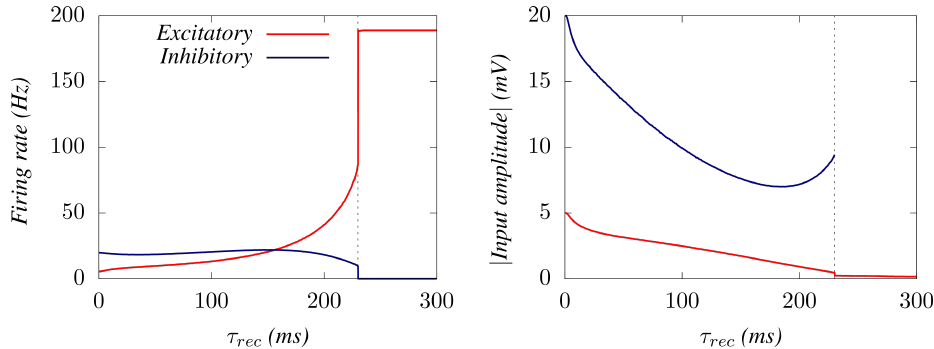
Figure 4. ( Left ) Average firing rates for E and I neurons as the level of STD is increased until the explosive transition occurs, for an external depolarizing noise level µ = 3. ( Right ) Corresponding |(cid:105) . This illustrates how the transition occurs because average synaptic current amplitudes (cid:104)| U · x t sp of a cease of firing of I’s due to the heavy synaptic depression of E’s. Beyond the transition point, excitatory neurons fire ceaselessly, further increasing their synaptic depression level.